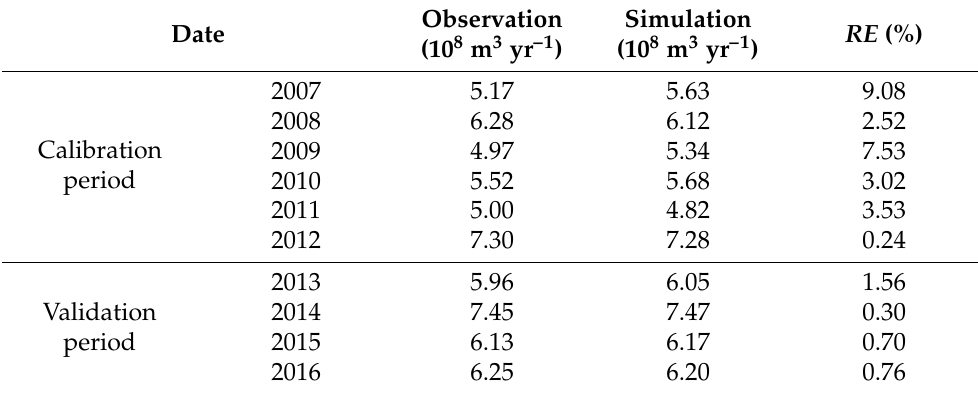
Table 4. Comparison of measured and simulated annual